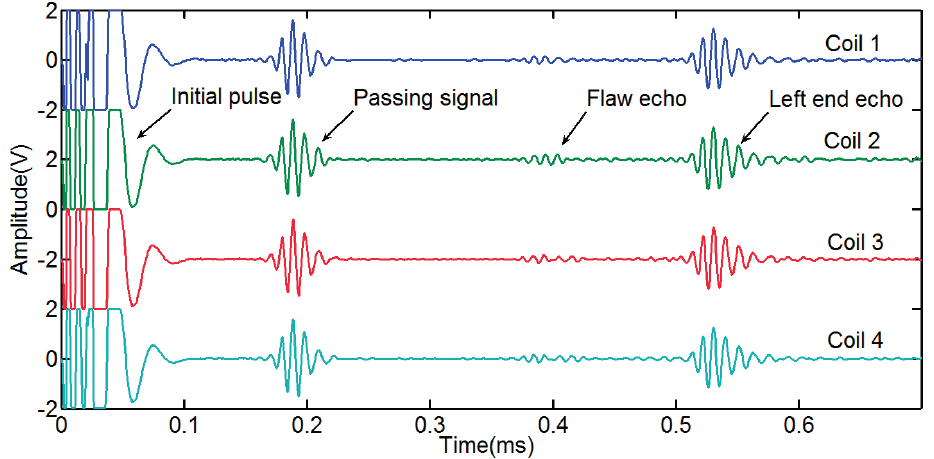
Figure 8. Receiving signals induced by the four coils of the prototype sensor.